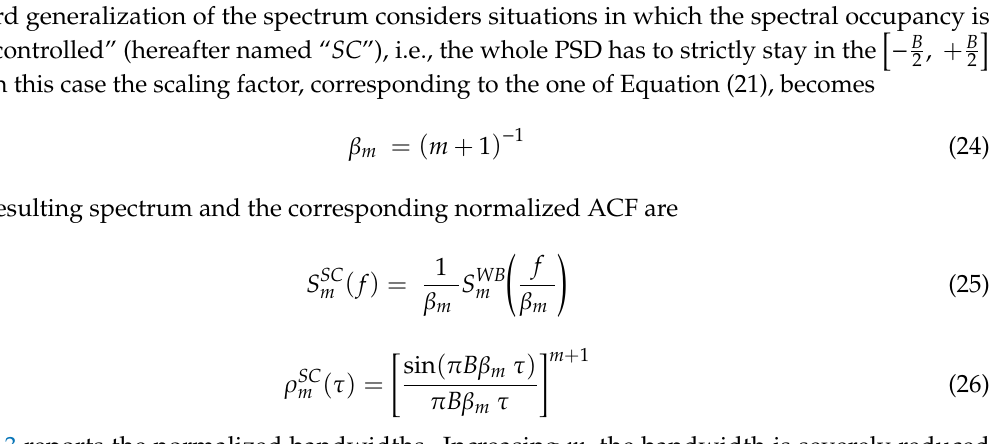
Figure 8. Spectrum of the “SC” noise waveforms (estimated on 1000 trials), BT = 5000, (cid:1865) = 1, 2 , 5.